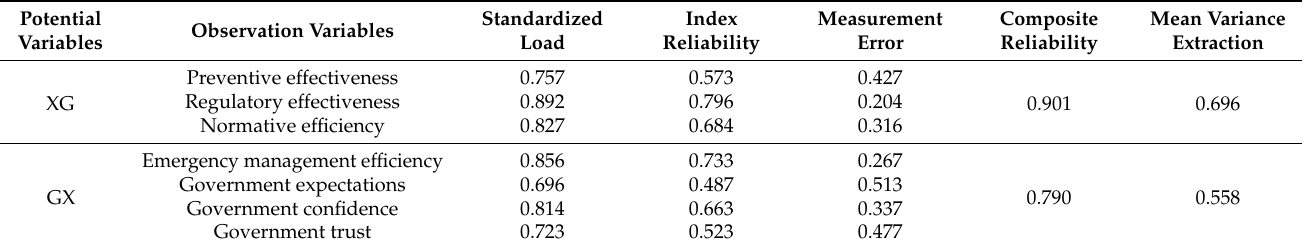
Table 4. Test results of internal structure suitability of the model by confirmatory factor analysis.